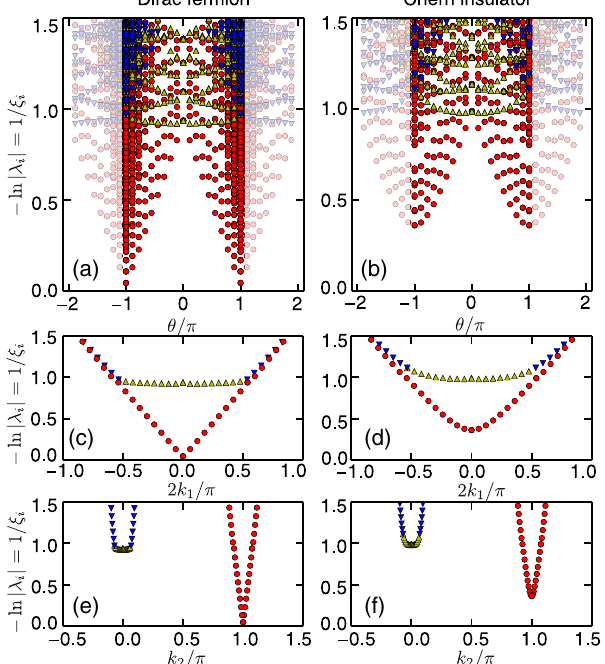
FIG. 8. Transfer matrix spectrum for free fermions [Eq. (3)] on the YC8-2 cylinder with bond dimension m ¼ 3000 . Here, we compare the free Dirac fermion model and a Chern insulator: the inverse of correlation lengths 1 = ξ versus (a,b) twist angle, (c,d) momentum 2 k 1 , and (e,f) momentum k 2 . The Chern insulator we show here is obtained by assigning π = 25 flux in the up and down triangles (of the kagome), and 23 π = 25 flux in the